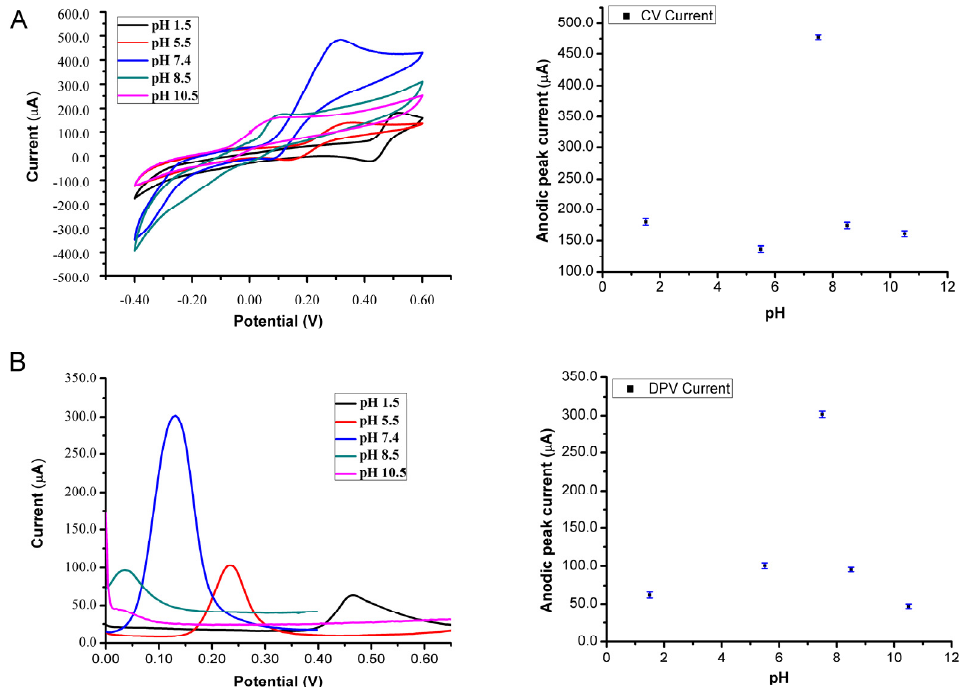
Figure 3. Optimization of the working pH for DA by voltammetry methods in different buffers at room temperature. ( A ) The detection of DA by CV in the different pH ranges of buffer solutions; ( B ) The detection of DA by DPV in the different pH ranges of buffer solutions.